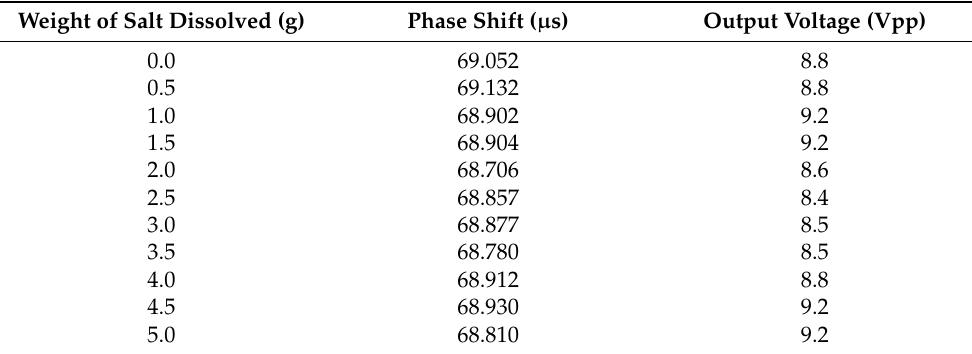
Table 2. Results of the effects of change in dissolved salt concentrations.